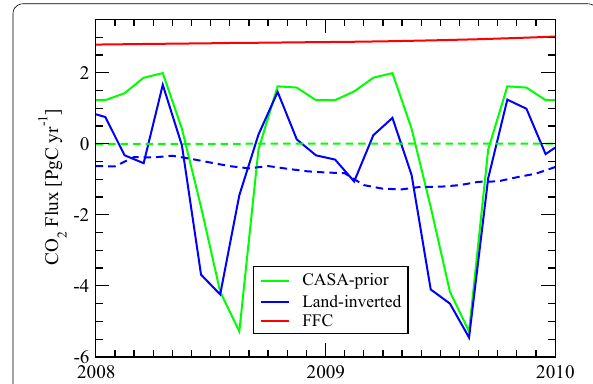
Fig. 4 Monthly time variations of FFC CO 2 emissions and land CO 2 fluxes as simulated by the a priori model (CASA; annually balanced to no net fluxes) and that estimated by the inverse model for East Asia. Broken lines are for 12-month running mean CASA ( green ) and inver- sion ( blue )